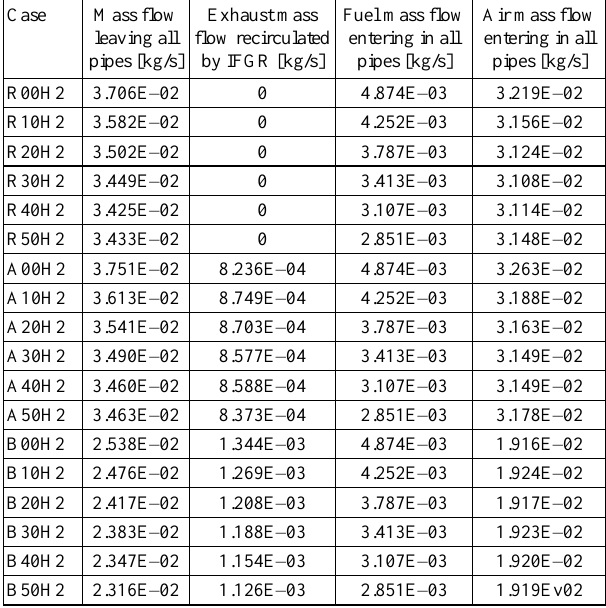
Table 5. Mass flows after IFGR system implementation